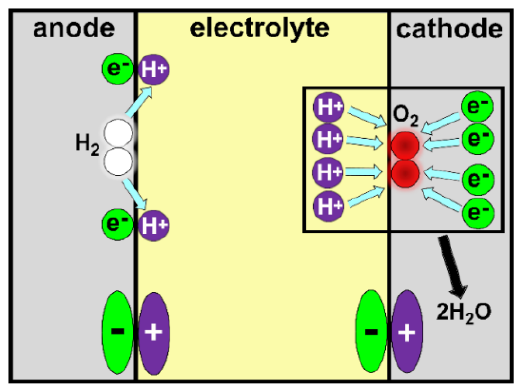
Figure 18. Sketch of the electrochemical process in a fuel cell when an acidic solution is used as electrolyte.